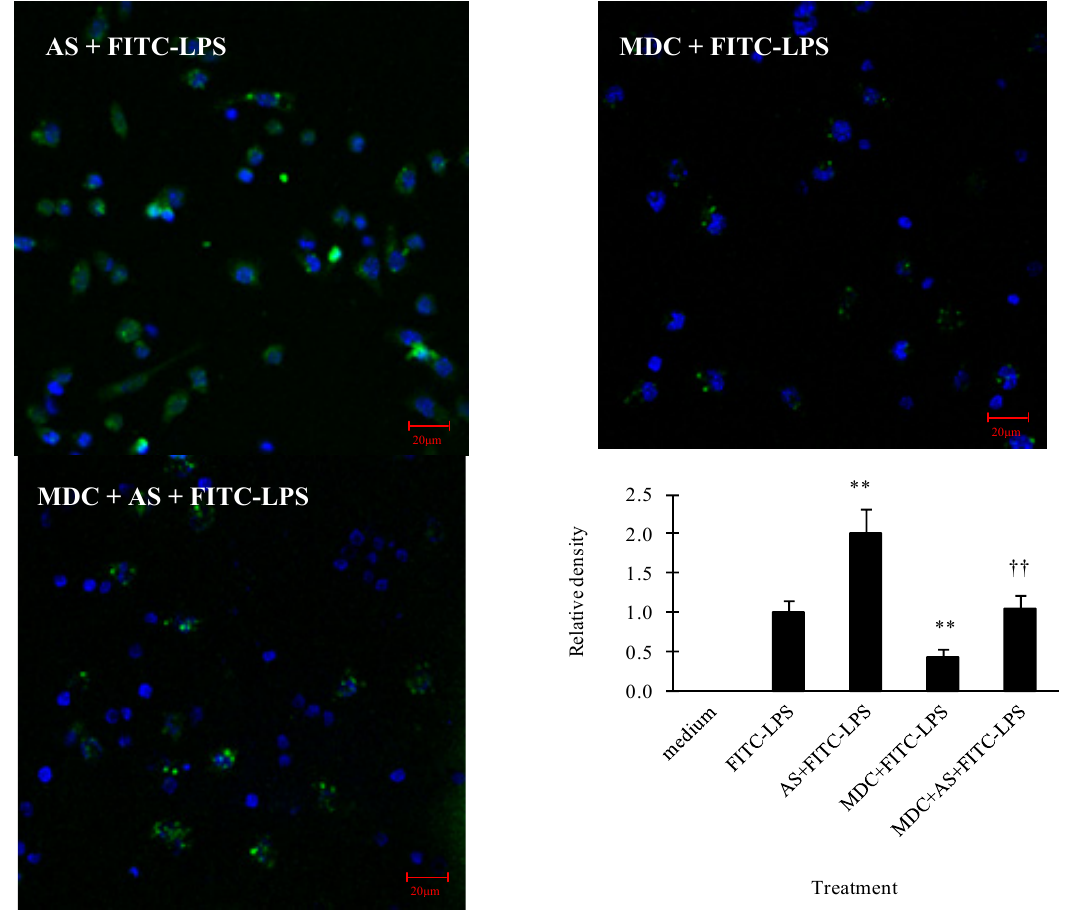
Figure 6. Effect of AS on LPS internalization by mouse liver Kupffer cells (400×). Mouse Kupffer cells (1.0 × 10 6 /mL, 500 μ L) grown on glass coverslips were pretreated as described in Figure 5. After washing and fixation, the nuclei were stained with DAPI. The distribution of FITC-LPS in cells was observed by laser confocal microscope. Images were captured and processed using the LSM Image Examiner software. ** p < 0.01 as compared to FITC-LPS, †† p < 0.01 as compared to MDC + FITC-LPS. medium